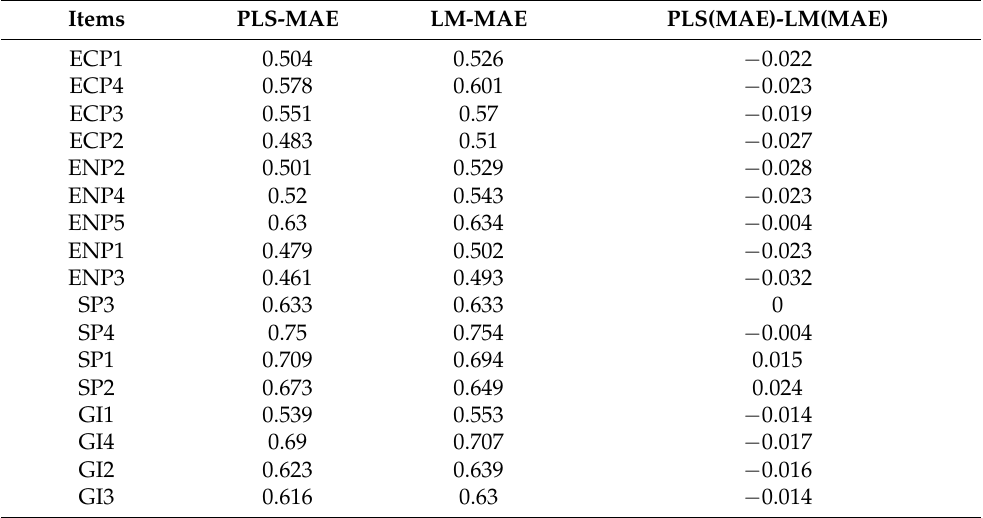
Table 5. PLSpredict assessment of manifest